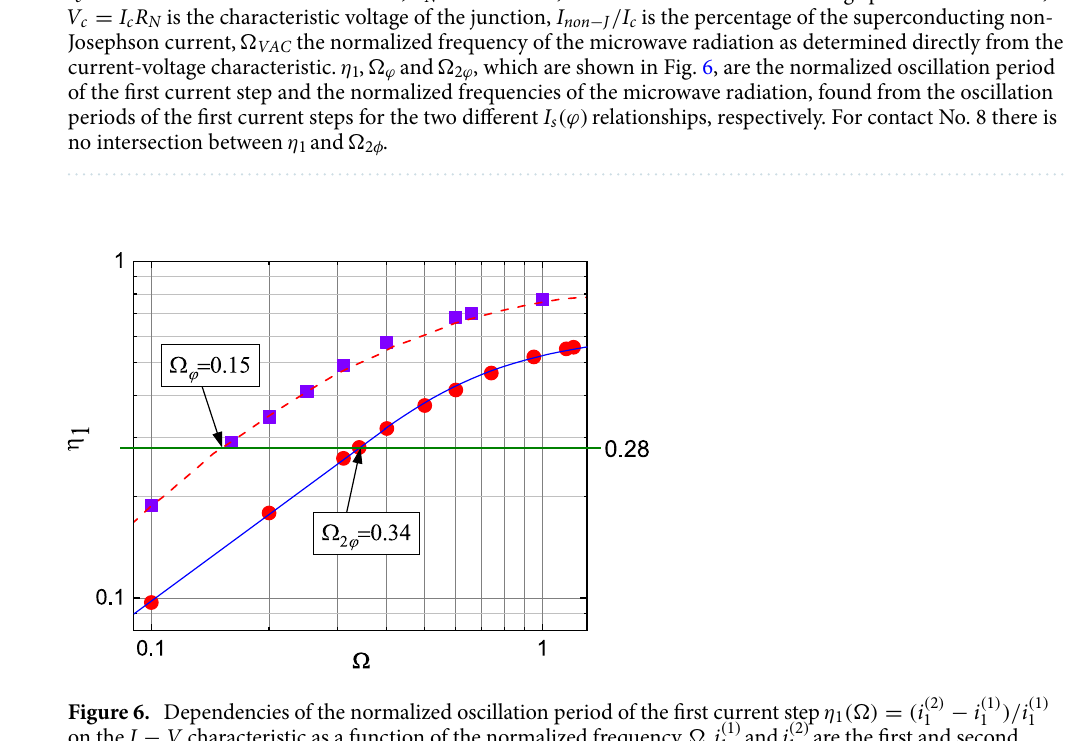
Figure 6. Dependencies of the normalized oscillation period of the first current step η 1 (�) = ( i on the I − V characteristic as a function of the normalized frequency, (cid:31) . i minimum in the amplitude dependence of the first current step, calculated from Eq. (1). Red dashed line: η 1 (�) dependence calculated by Likharev 49 for I s = I c sin (ϕ) . Violet squares and red circles: η 1 (�) for I s = I c sin (ϕ) and I s = I c sin ( 2 ϕ) calculated in this work, respectively. Solid blue line: approximations of the values indicated by the red circles. For point contact No. 1 we obtained η 1 = 0.28 , which corresponds to � ϕ = 0.15 and � 2 ϕ = 0.34